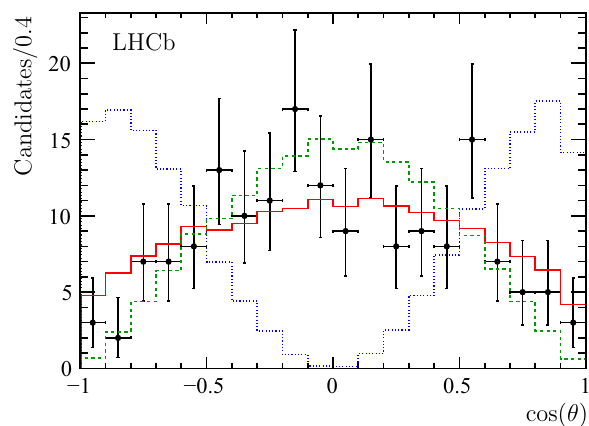
Fig. 10 The invariant mass distribution of each combination of φφ pairs in the B 0 s → φφφ candidates. The B 0 s candidates are constrained to the known B 0 s mass. A phase-space distribution as obtained from simulation ( red histogram ) is overlaid